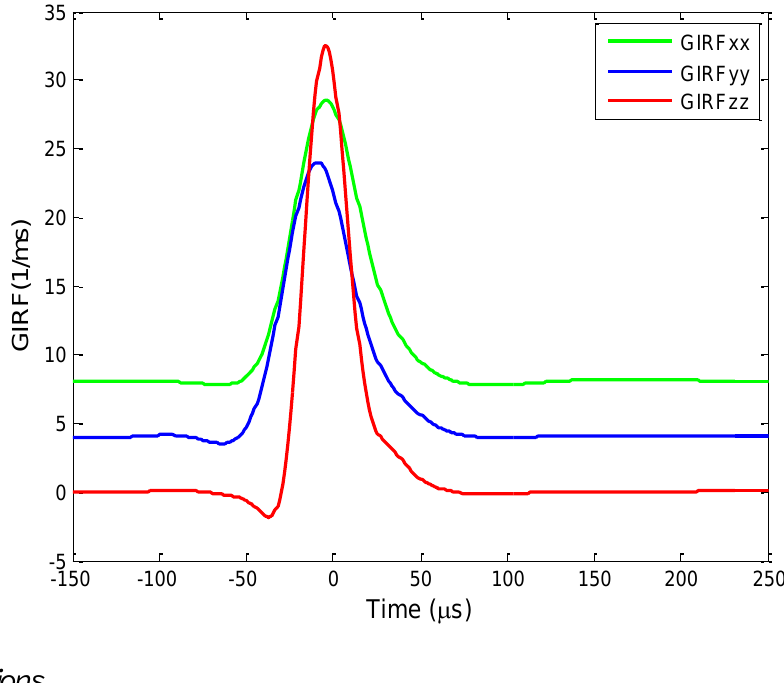
Figure 3. Time domain plots of the GIRFs in the three gradient directions. The plots are offset in the vertical direction for clarity. All plots show amplitudes prior to zero time. The higher frequency response of the z gradient results in a narrower GIRF in the time domain. While the peak amplitudes of the x and z GIRFs occur close to zero time, the y GIRF peak amplitude occurs at slightly negative